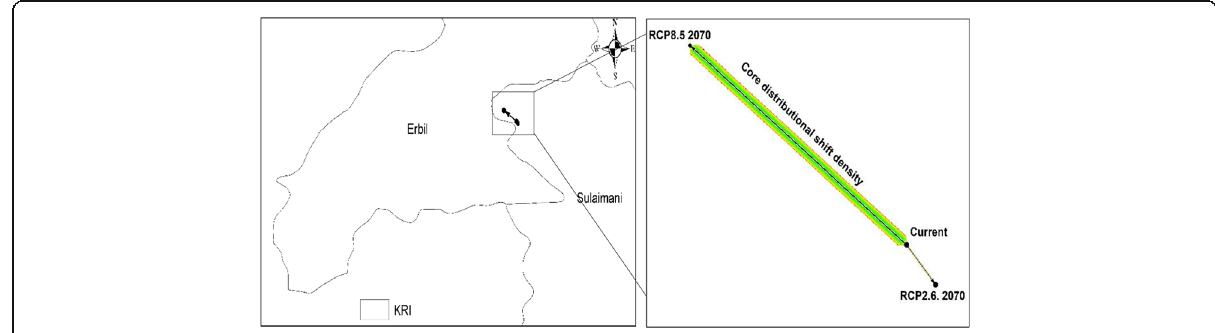
Fig. 10 Current centroid distribution of Q. aegilops and distributional centroid changes under RCP2.6 2070 and RCP8.5